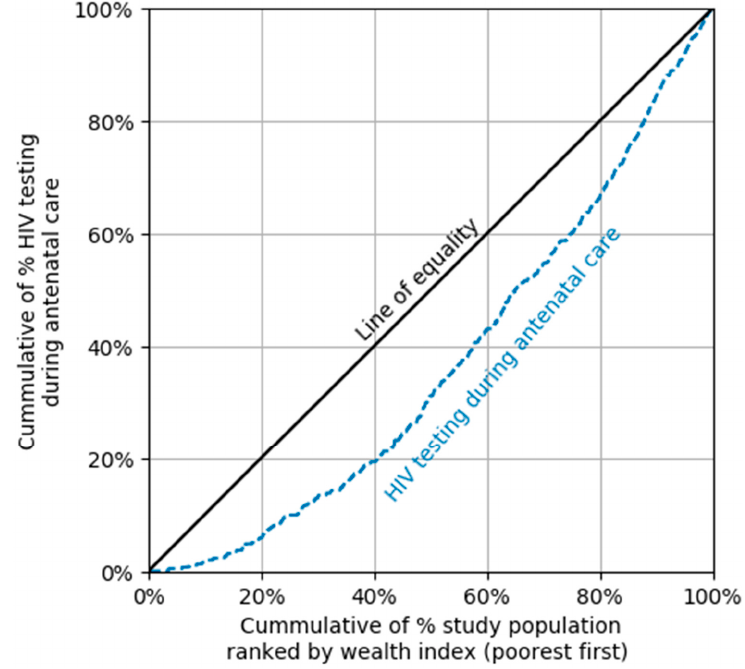
Figure 1. Concentration curve (CC) of HIV testing during antenatal care among women aged 15–49 years who had a live birth in the last two years, by wealth index. Table 4. Multivariable logistic regression of factors associated with HIV testing during antenatal care among women aged 15–49 years who had a live birth in the last two years.